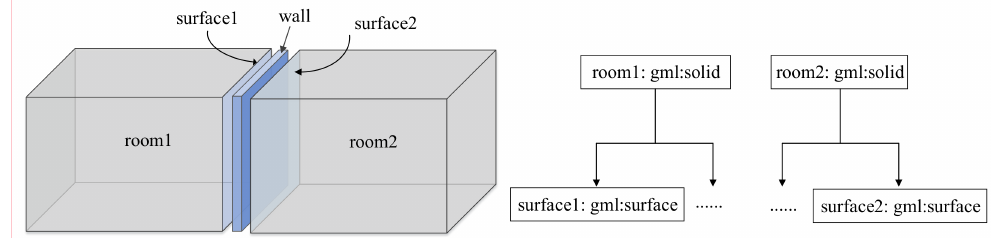
Figure 3. Representation of interior rooms in City Geography Markup Language